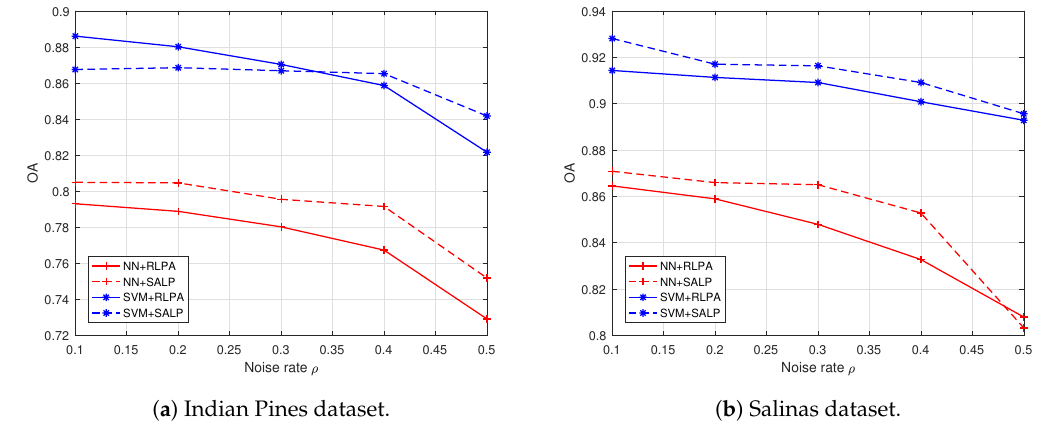
Figure 6. OA trend of RLPA and SALP over NN and SVM with the “random” Setting. The proposed SALP is marked by imaginary line, and the RLPA is marked by solid line. The results of NN is labeled in red “+”, and that of SVM is labeled in blue “*”.